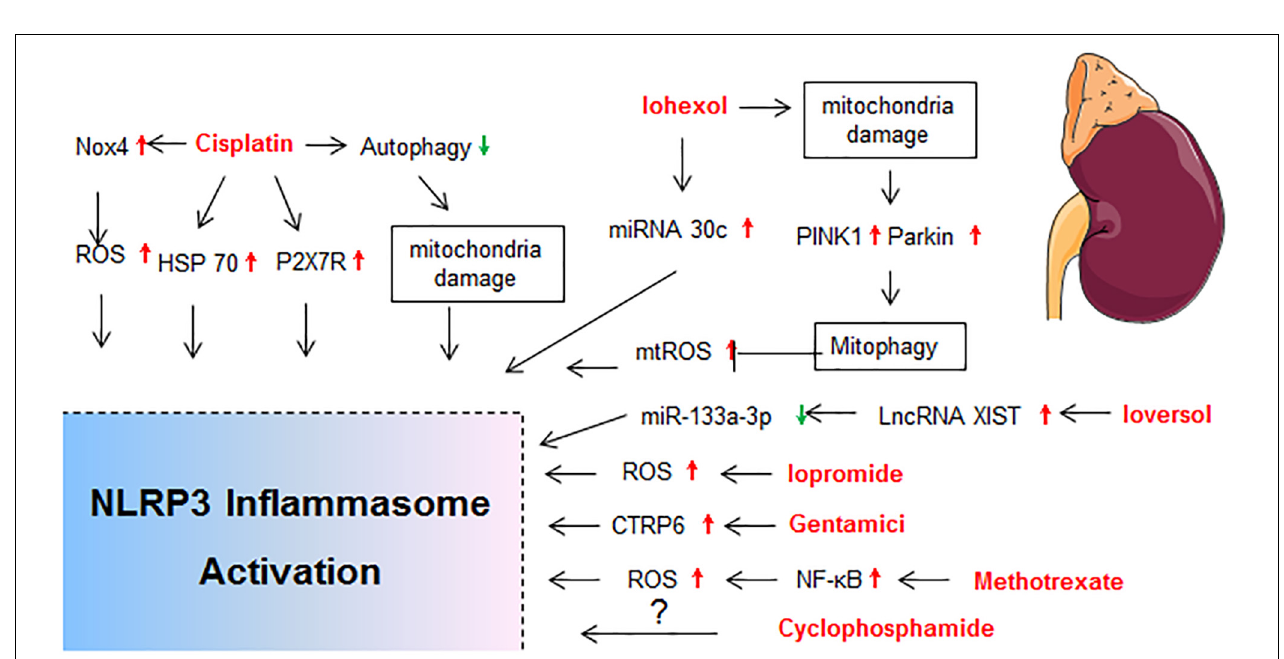
FIGURE 3 | Molecular mechanisms of NLRP3 activation in drug-induced nephrotoxicity. BNIP3, BCL2/adenovirus E1B interacting protein 3; HIF-1 α , hypoxia inducible factor 1, alpha subunit; HSP70, heat shock protein 70; LncRNA XIST, long non-coding RNA X-inactive specific transcript; MTECs, mouse tubular epithelial cells; P2X7R, P2X purinoreceptor 7 receptor; TECs, tubular epithelial cells.